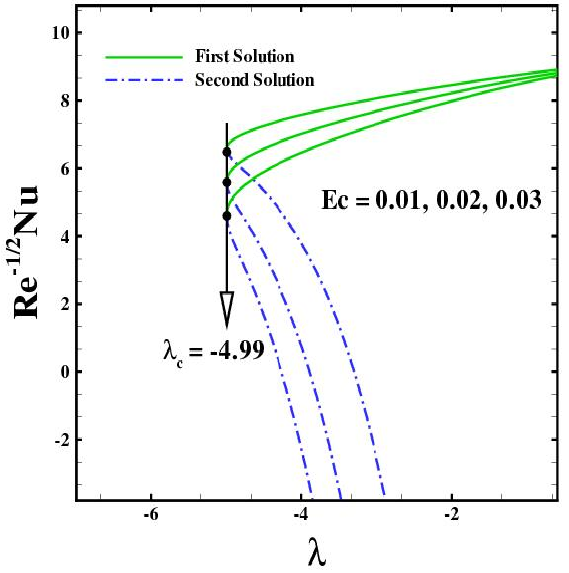
Figure 6. Impact of Re − 1/2 Nu with λ for various values of Ec and n = Pr = 2, S = 4.5, We = β = 0.3, M = 0.5, and A = B = 0.01.